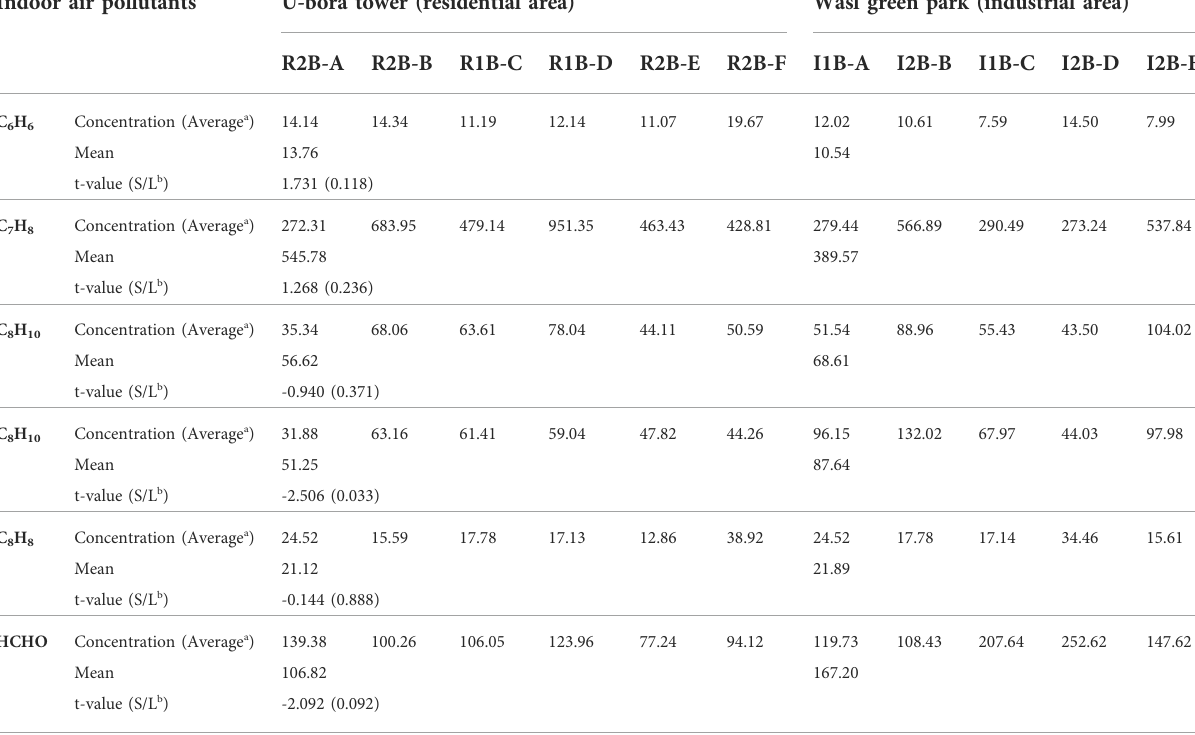
TABLE 4 Difference veri fi cation ( t -test) result of indoor average concentration by building type.